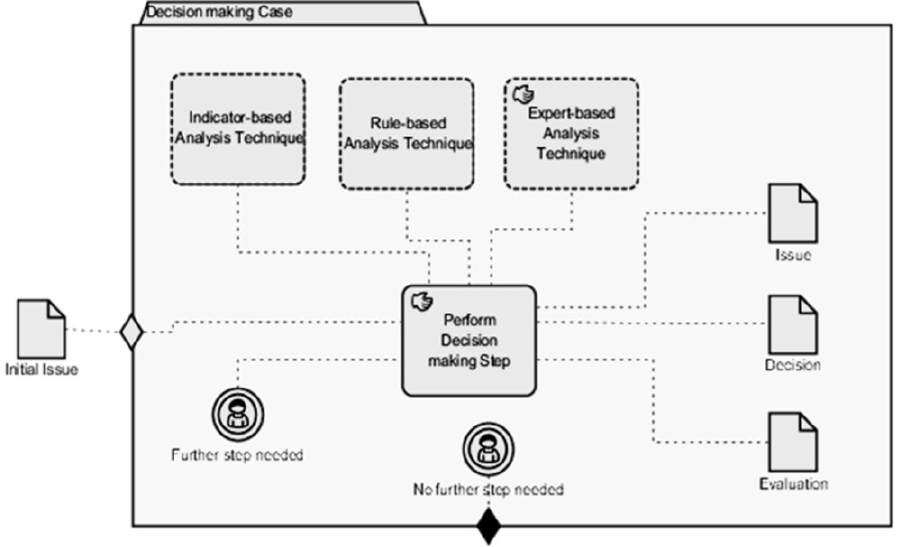
Figure 4. CMMN Model of Collaborative Decision Making Case